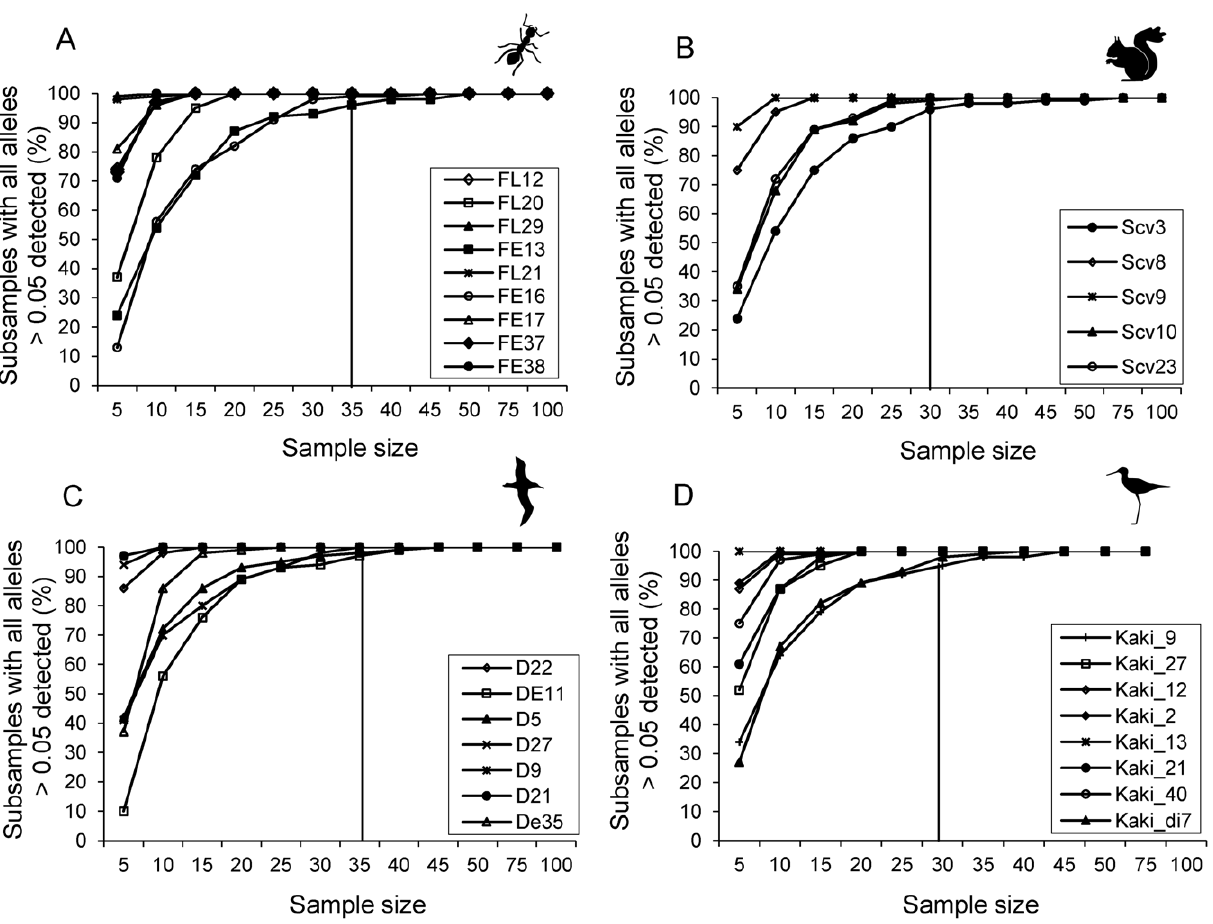
Figure 1. Impact of sample size on allele detection. Percentage of samples in which all alleles at a real frequency $ 0.05 at each locus were detected at each sample size (of the 100 random replicates per size), for A) the ant dataset, B) the squirrel dataset, C) the albatross dataset and D) the kakı¯ dataset. The vertical line shows the sample size at which all alleles at a real frequency $ 0.05 at all loci were detected in $ 95% of replicates.